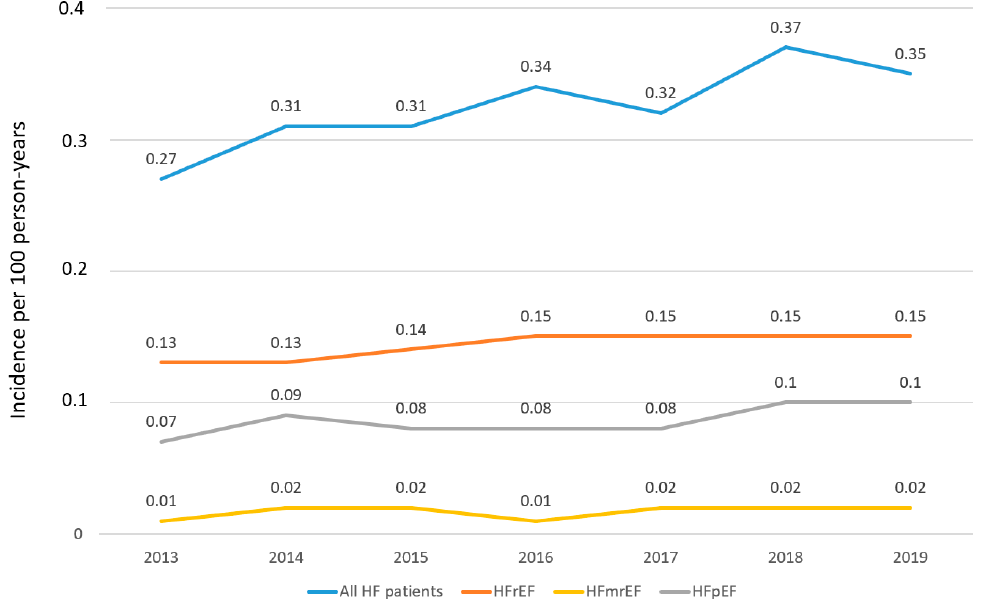
Figure 1. Incidence rates of HF. Abbreviations: HF = Heart failure; HFmrEF = Heart failure with mildly reduced ejection fraction; HfpEF = Heart Failure with preserved ejection fraction; HFrEF = Heart failure with reduced ejection fraction; HfuEF = Heart Failure with un-specified ejection fraction. Data were recorded until September 2019.